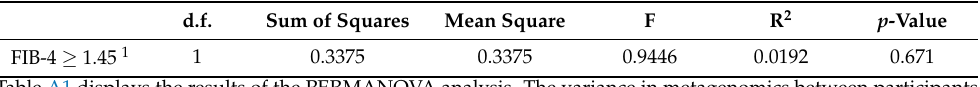
Table A1. Permutational multivariate analysis of variance (PERMANOVA) metagenomics analysis (UniFrac similarity) 1 .